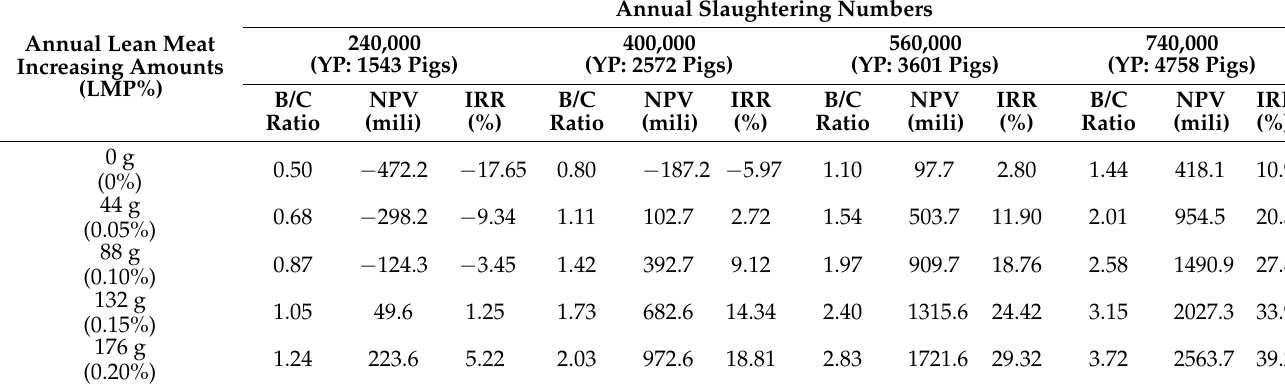
Table 5. Sensitivity analysis according to annual slaughter volume difference and annual lean meat percentage